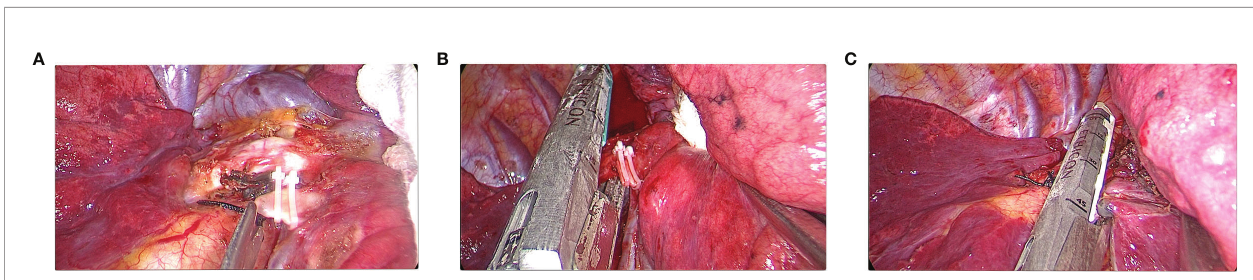
FIGURE 1 | The main steps of the aBVA procedure. (A) Cutting the posterior ascending artery ( “ a ” in aBVA), (B) stapling the upper bronchus, and (C) stapling the upper arterial branches (including variant arterial branches) as well as upper vein